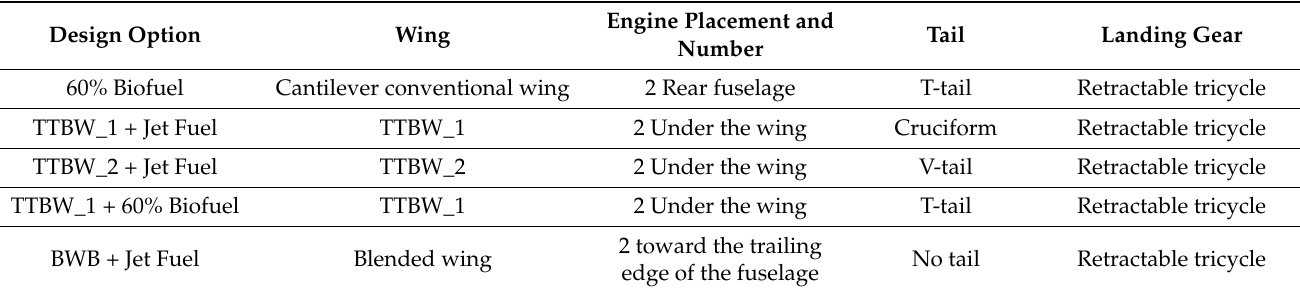
Table 1. The final designs’ configuration options to be analyzed using the PUGH method. Design